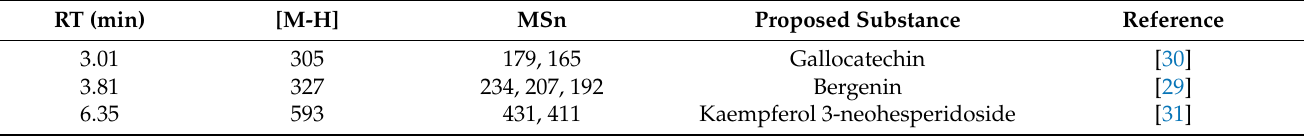
Table 3. Identification of the substances present in the Humiria balsamifera (Aubl) methanol stem bark extract.